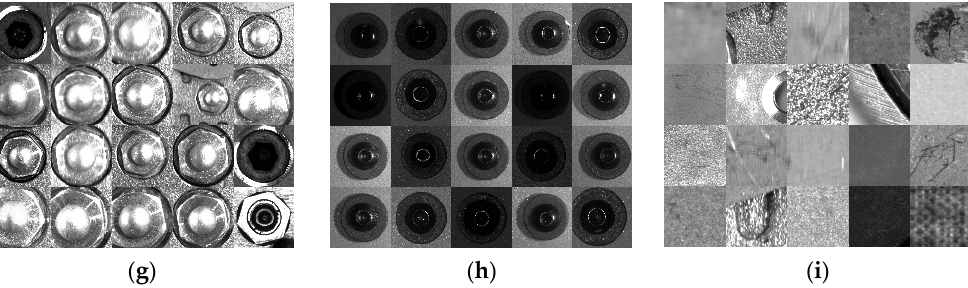
Figure 6. Categorized images using the Patch Classifier interface, with ( a ) drill; ( b ) countersink; ( c ) rivet; ( d ) protruding rivet; ( e ) temporary fastener 1; ( f ) temporary fastener 2; ( g ) hexagonal; ( h ) screw; and ( i ) background categories.